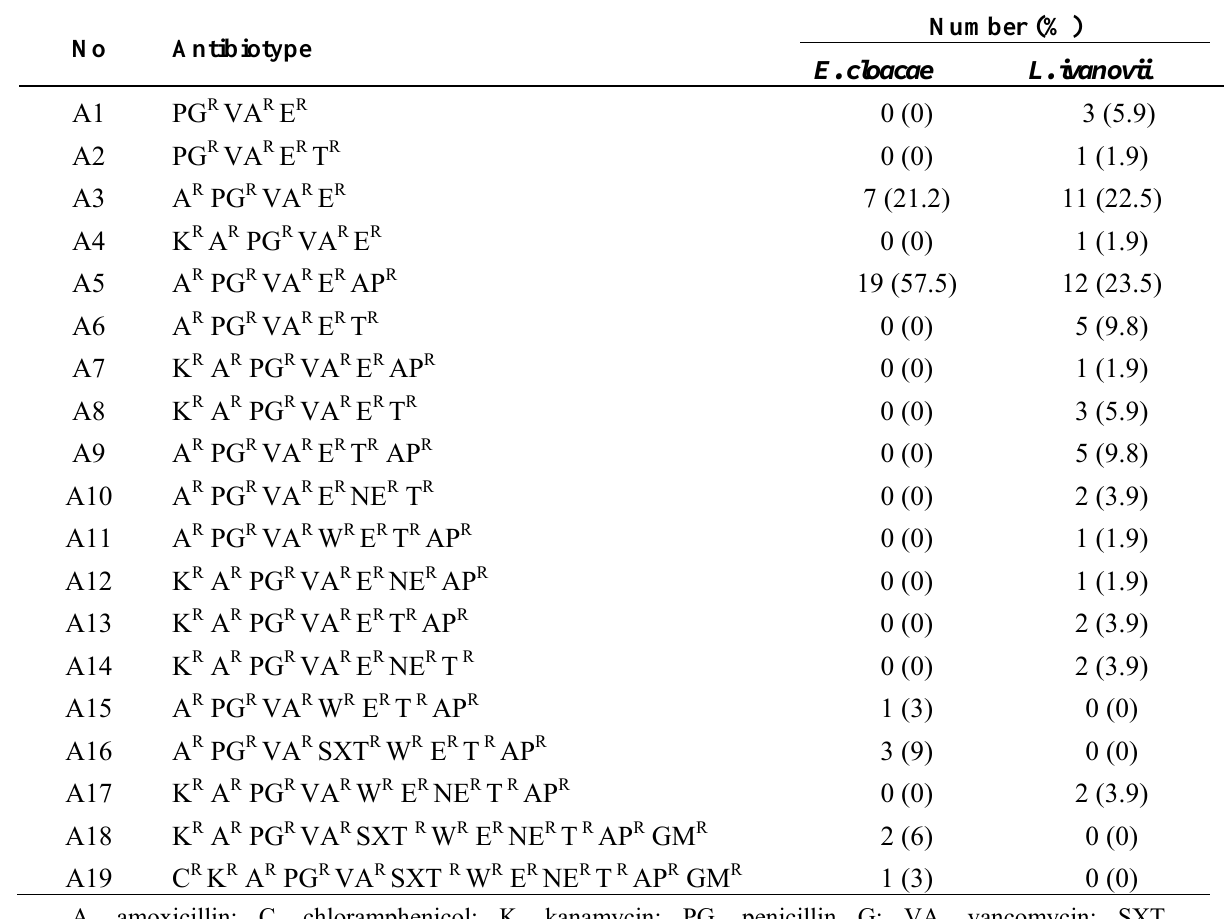
Table 2. Antibiotypes of E. cloacae and L. ivanovii